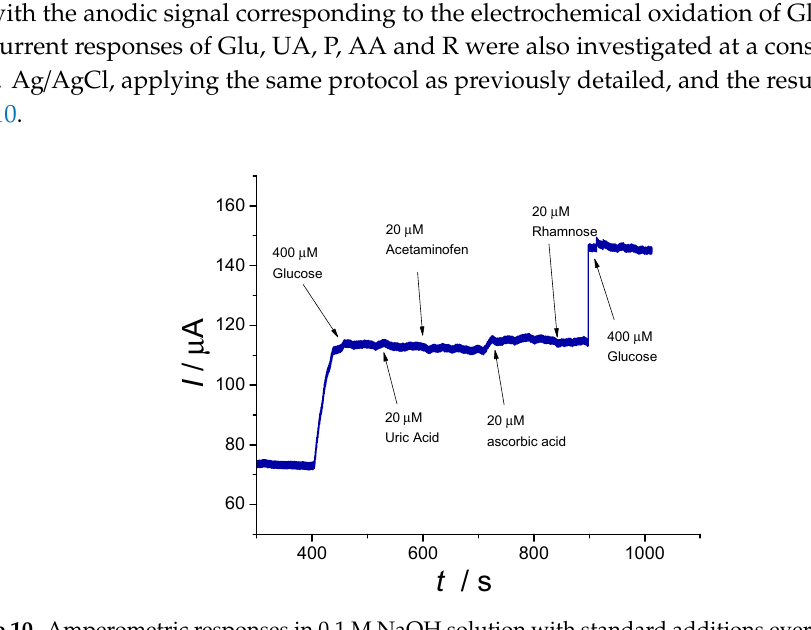
f electrode (working